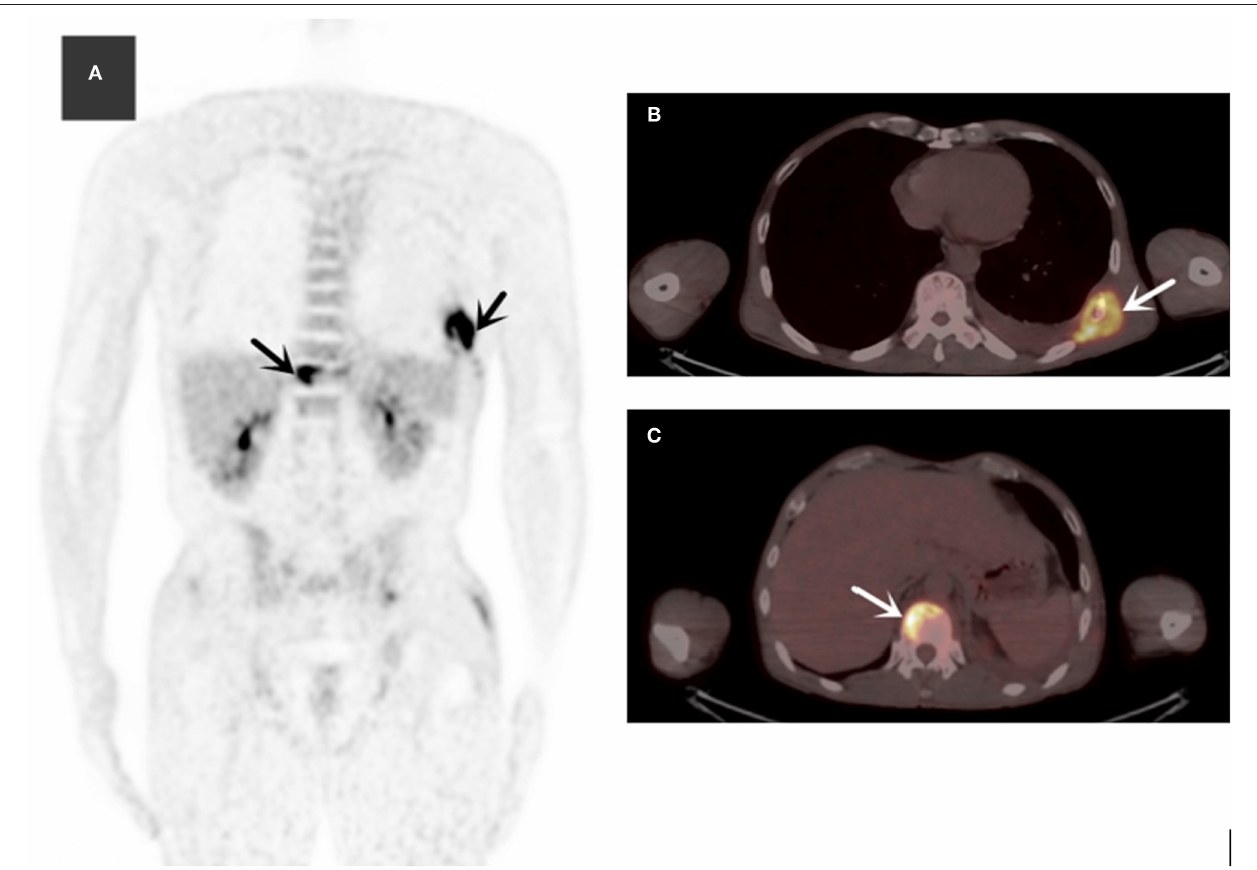
FIGURE 2 | The MIP (maximum intensity projection) of 18F-FDG (fluoro-D-glucose) PET/CT (A) revealed multiple hypermetabolic lesions in the whole body (black arrows). Axial slices showed normal ribs (B) (SUVmax = 10.3) and multiple hypermetabolic lesions of the spine (C) (white